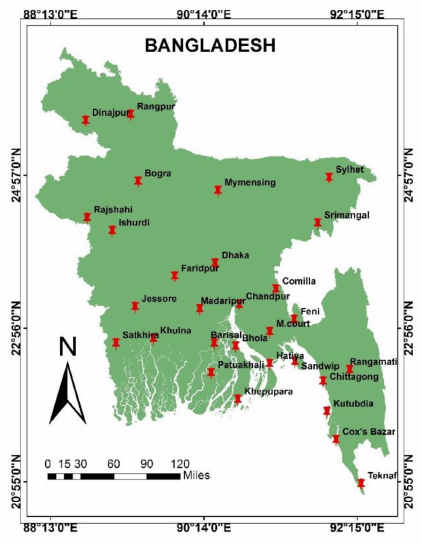
Figure 1. Meteorological stations over Bangladesh used in this study.